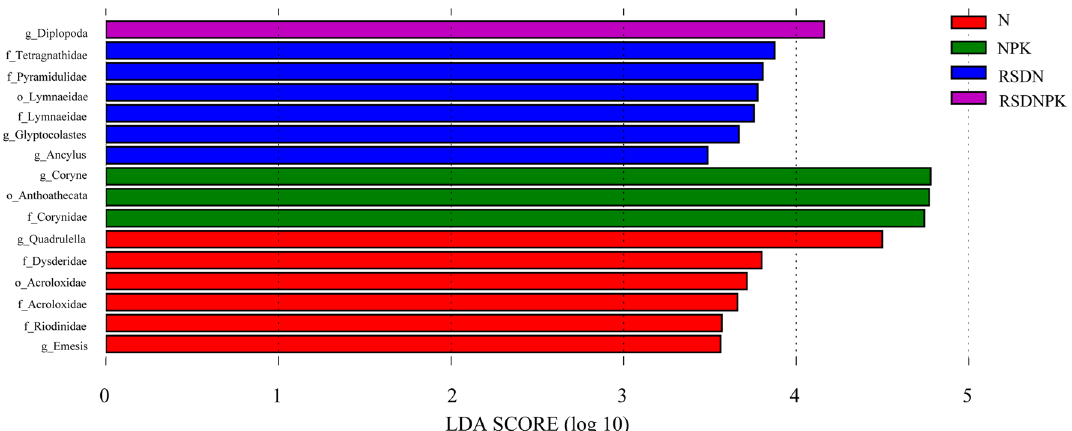
Figure 2. LEfSe analysis of soil faunal taxa in different fertilization treatments. The LDA score represents the different sizes among fertilizer treatments with a threshold value of 2. N synthetic N fertilizer, NPK synthetic fertilizer: nitrogen, phosphorus and potassium, RSDN crop residues returned with nitrogen, RSDNPK crop residues returned with nitrogen, phosphorus and potassium.